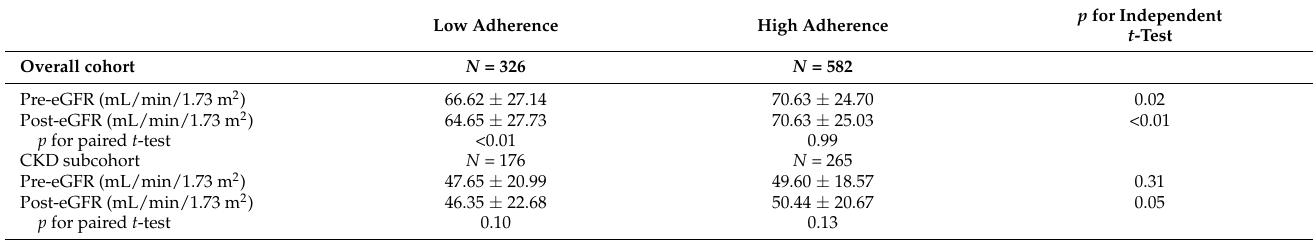
Table 2. Comparison of renal function in patients with denosumab treatment in the overall cohort and the chronic kidney disease subcohort.